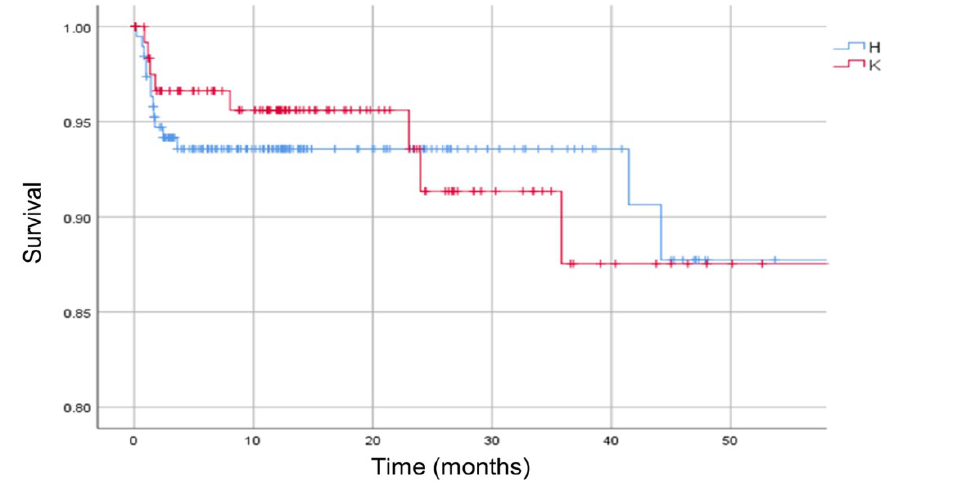
Figure 5. Kaplan-Meier survival curve. The analysis is separated in hip (H) and knee (K) infections. Vertical marks indicate censoring.